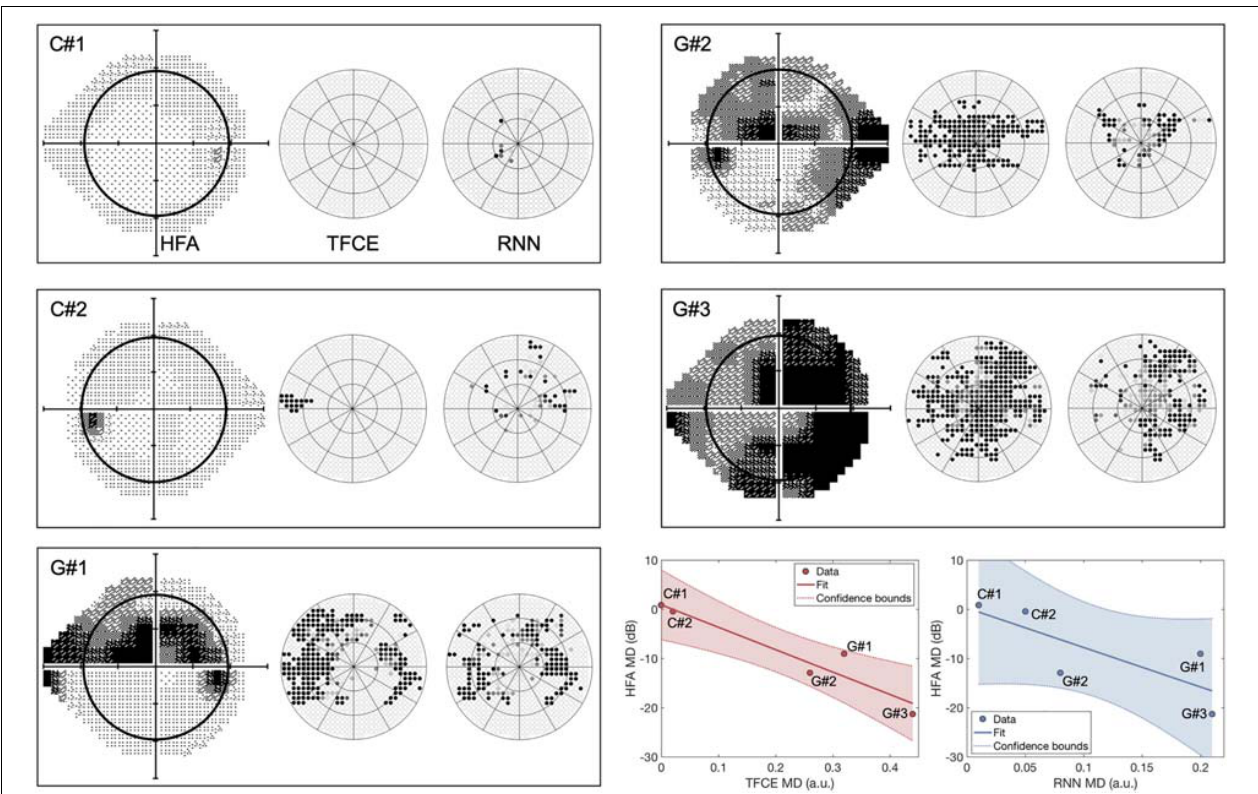
FIGURE 10 | Perimetric maps of the five patients tested with our continuous tracking test. The TFCE maps are reconstructed using as λ n the average of the values obtained by each fold (see Figure 6 ). C#1 and C#2 are healthy controls, while G#1, G#2, and G#3 and patients previously diagnosed with Primary Open Angle Glaucoma. The black circle within the HFA maps represents the portion of the visual field covered by the TFCE and RNN maps. The TFCE method shows a significant correlation between its Mean Deviation index and the one obtained with the HFA, whereas the RNN method does not ( R 2 TFCE = 0 . 88, p TFCE = 0.0117; R 2 RNN = 0 . 49, p RNN =